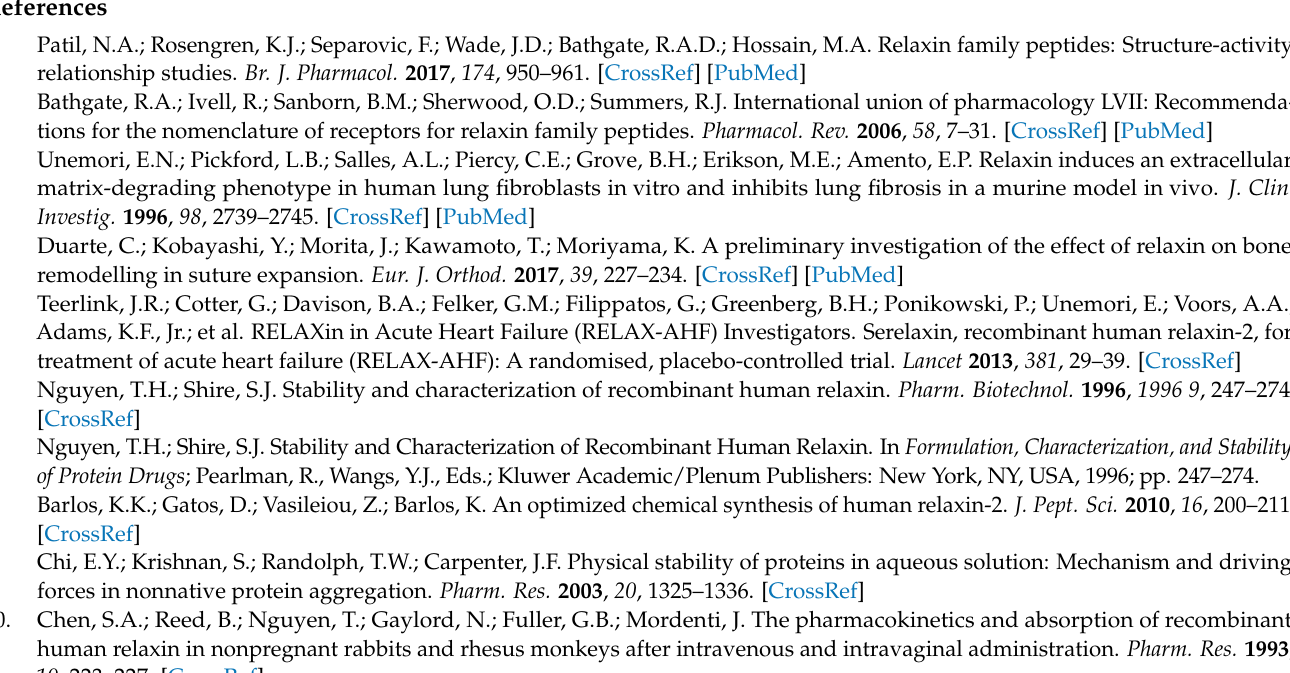
solution; Figure S2: Standard curve of RLX2 in PBS (A) or 80% FBS (B); Figure S3: Standard curve of O-RLX2 in PBS solution; Figure S4: Standard curve of O-RLX2 in PBS (A) or 80% FBS (B); Figure S5: Representative graphs of liposome size